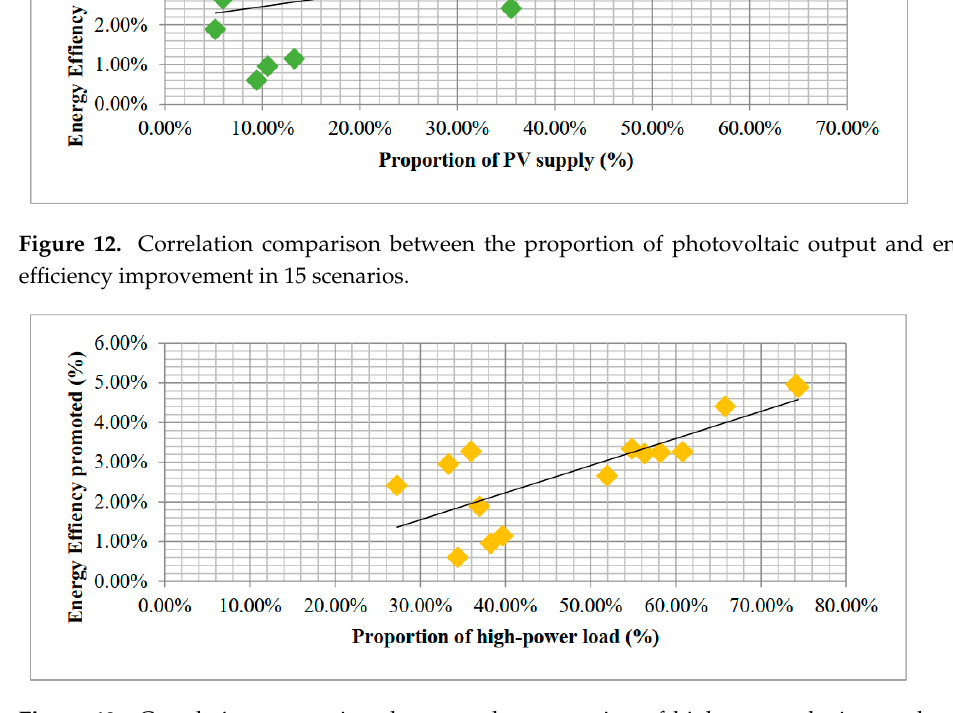
Figure 13. Correlation comparison between the proportion of high-power devices and energy efficiency improvement in 15 scenarios.